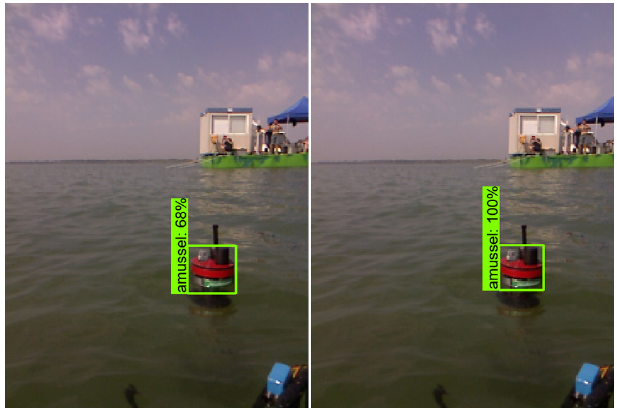
Figure 14. Detection ( left ) vs. ground truth ( right ) mid-training example for the SSD Mobilenet V2